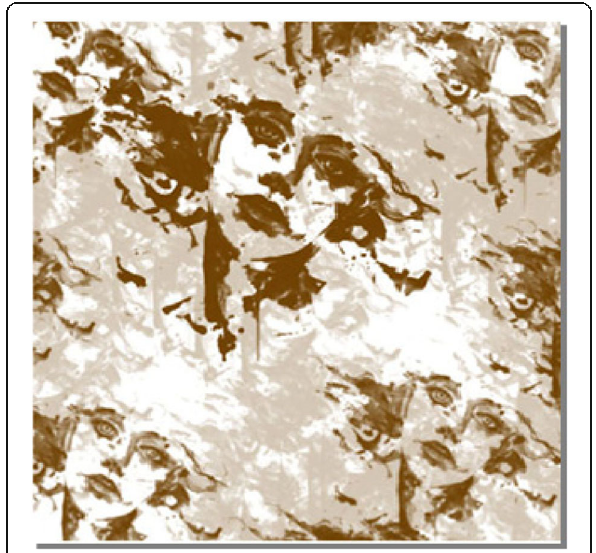
Fig. 4 Computer digital simulation tie-dye pattern. (The second is to